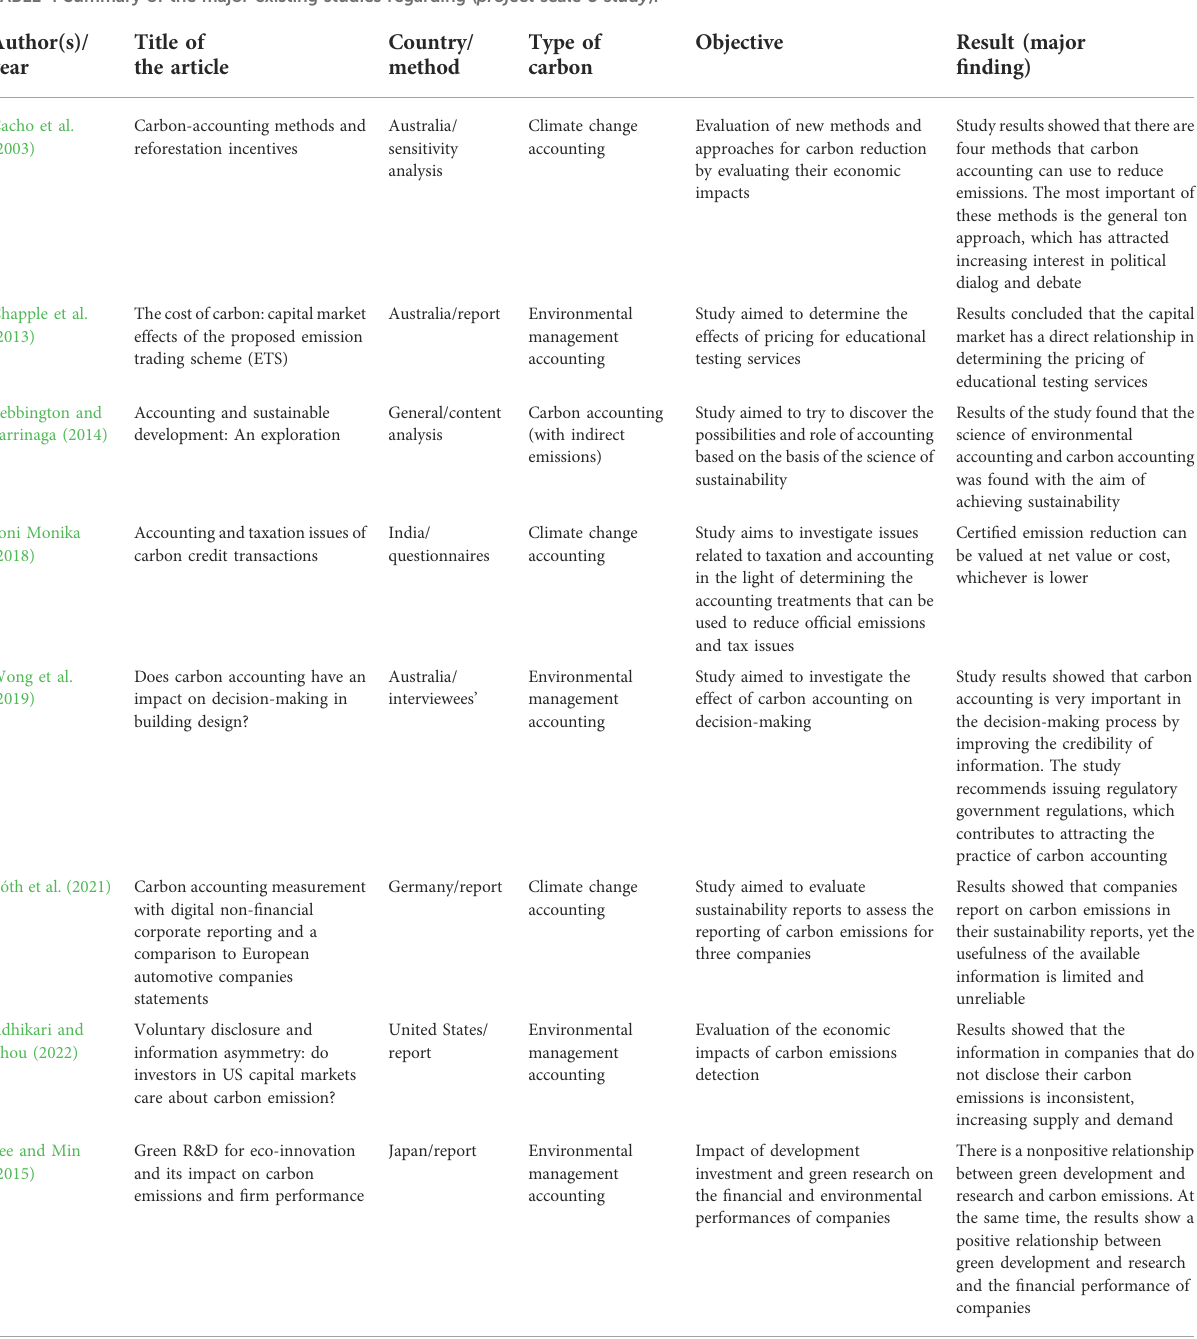
TABLE 4 Summary of the major existing studies regarding ( project scale 8 study